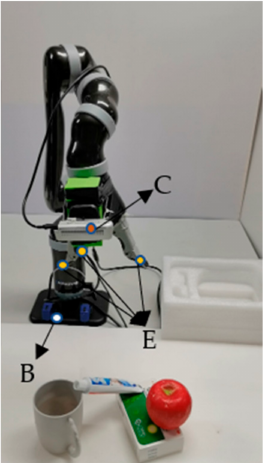
Figure 9. Coordinate System Declaration. Where B is the base coordinate system, E is the End Actuator Coordinate System, C is the camera coordinate